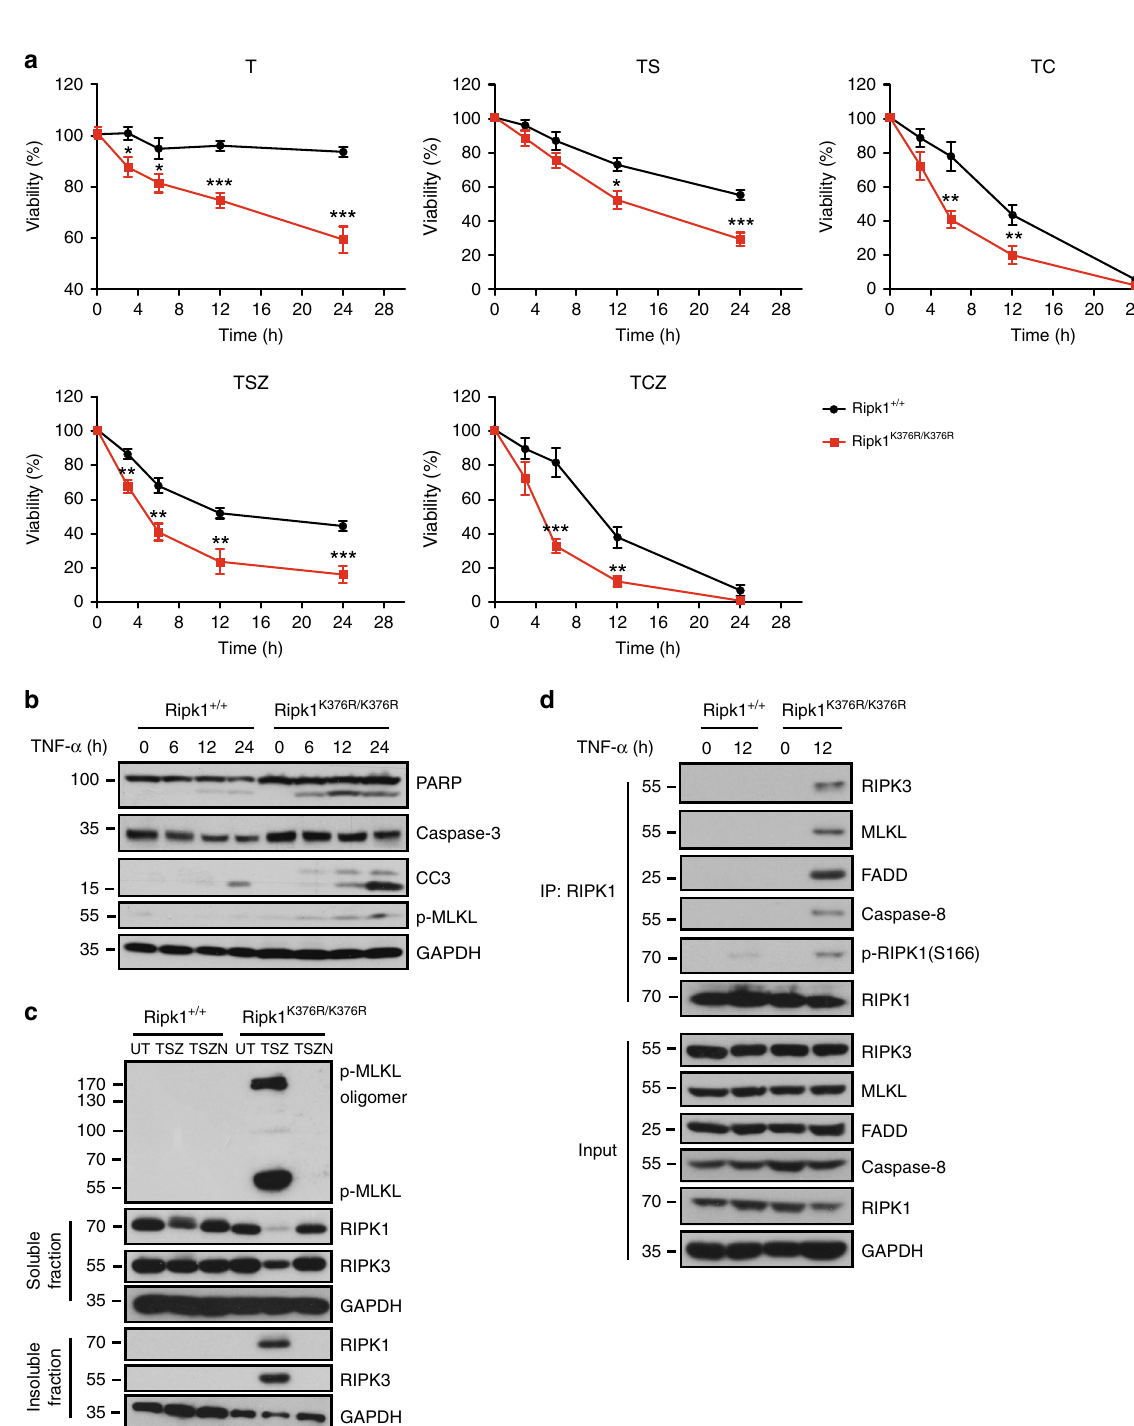
Fig. 3 Cells bearing RIPK1 K376R/K376R are more susceptible to TNF- α induced apoptosis and necroptosis. a Ripk1 + / + and Ripk1 K376R/K376R MEFs were treated with T, TS, TSZ, TC, TCZ for indicated times, respectively. Cell viability was determined using the CellTiter-Glo kit. The data are represented as the mean ± SEM of MEFs derived from 3 embryos. P values were determined by Student ’ s t -test (* p < 0.05, ** p < 0.01, *** p < 0.001). Abbreviations are as follows: UT untreated, TSZ TNF- α (20 ng/ml) + Smac mimetic(100nM) + zVAD(20 μ M); TSZN, TNF- α + Smac mimetic + zVAD + Necrostatin-1 (20 μ M); TC, TNF- α + CHX (20 ng/ml); TCZ, TNF- α + CHX + zVAD. Source data are provided as a Source Data fi le. b Ripk1 + / + and Ripk1 K376R/K376R MEFs were treated with mouse TNF- α (20 ng/ml) for indicated times, the cell lysates were analyzed by western blotting using the indicated antibodies. c Ripk1 + / + and Ripk1 K376R/K376R MEFs were treated with TSZ or TSZN for 3 h, the cell lysates were resolved on non-reducing gel and immunoblotted with anti-p-MLKL antibody. d Ripk1 + / + and Ripk1 K376R/K376R MEFs were treated with mouse TNF- α (20 ng/ml) for 12 h, anti-RIPK1 was used to immunoprecipitate complex and immunocomplexes were analyzed by western blotting using indicated